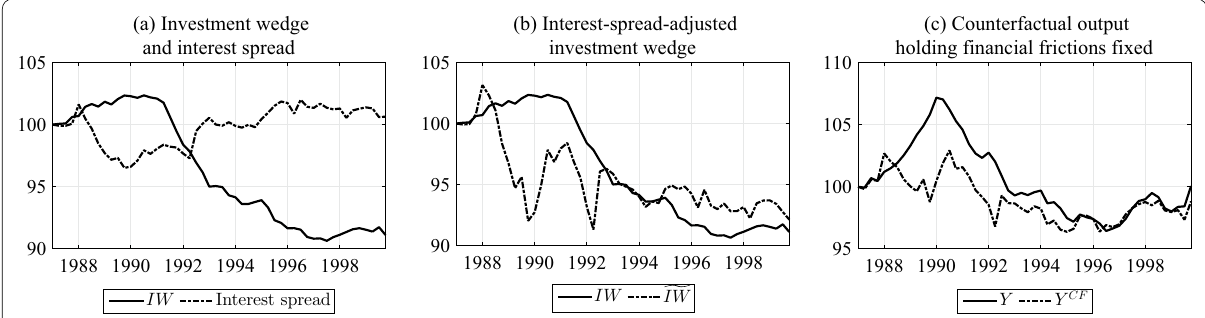
Fig. 18 Robustness: The role of disruptions in financial intermediation for ν = 0.5 (1987Q1–1999Q4). IW denotes the investment wedge, the interest spread corresponds to the spread between the lending and deposit rates obtained from the IMF International Financial Statistics, and is the interest-spread-adjusted investment wedge. Y is output and Y CF denotes the counterfactual path of output when holding financial frictions fixed